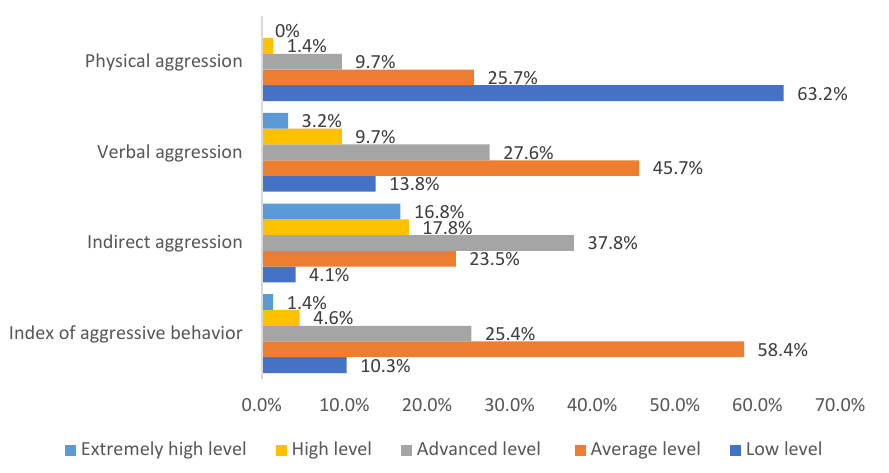
Figure 3. The frequency distribution of HCWs of non-COVID-19 ICUs by the levels of aggression and its components (physical, verbal, indirect, and index of aggressive behavior).